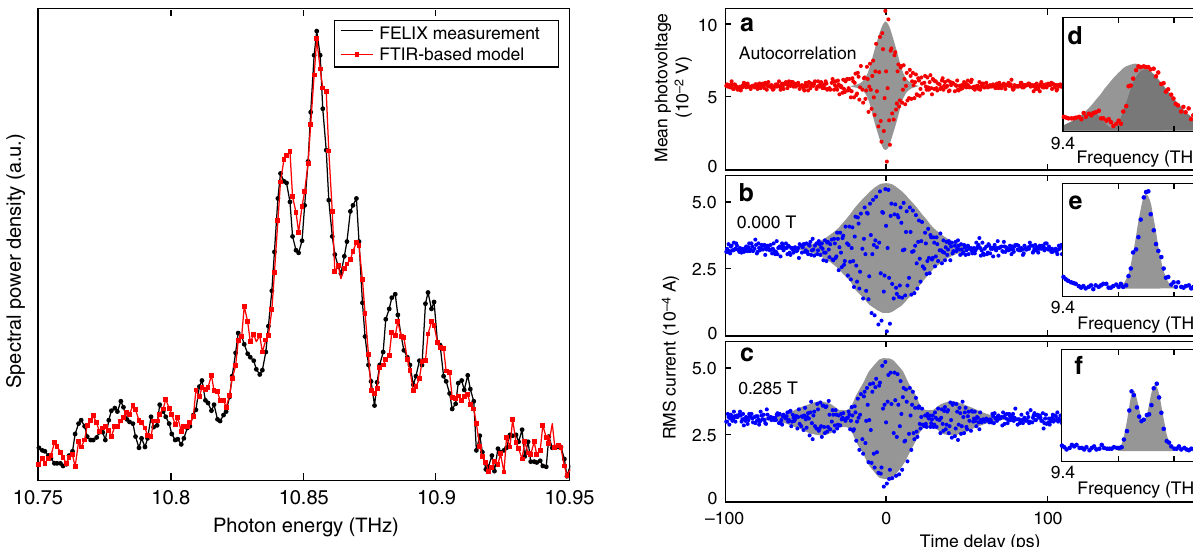
Fig. 6c are points at which the second pulse arrives when both excited states are in phase or 180 (cid:2) out of phase with each other (first and third rows of Figs 1d and 2a); they are equally doubled (maxima in the rapid oscillations at the average frequency) or destroyed (minima). The nodes in Fig. 6c, on the other hand, are points where the second pulse arrives when both excited states are 90 (cid:2) out of phase (second and fourth rows of Figs 1d and 3a); the second pulse transfers amplitude from one component to the other with no change in the total excited state population.